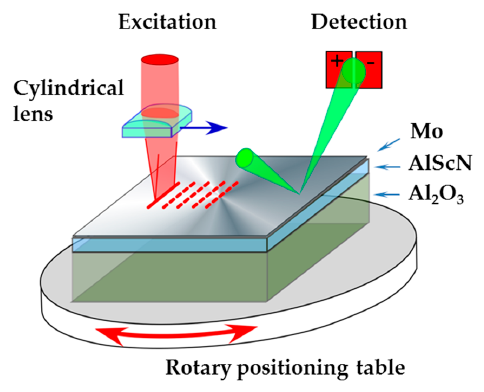
Figure 2. Experimental setup.